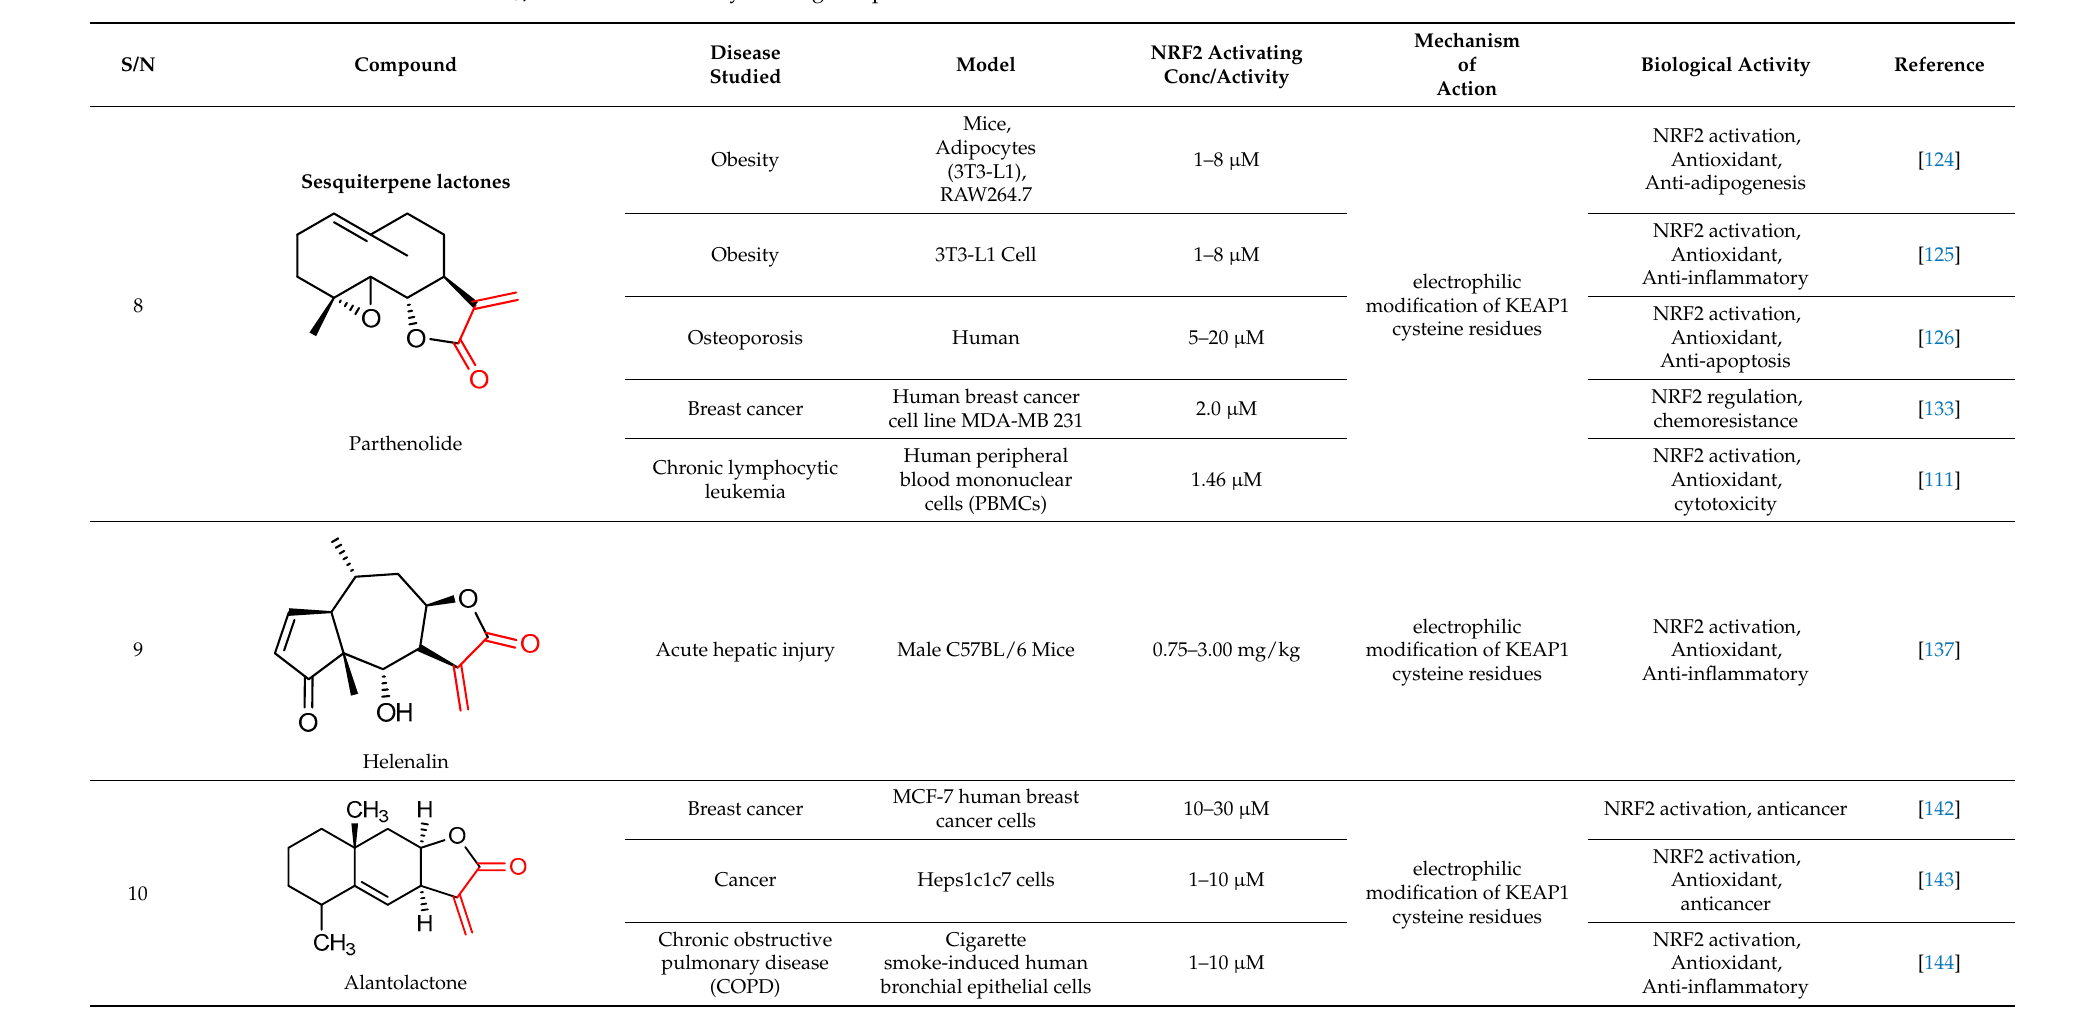
Table 1. α , β -Unsaturated moiety-bearing compounds as NRF2 activators/KEAP1